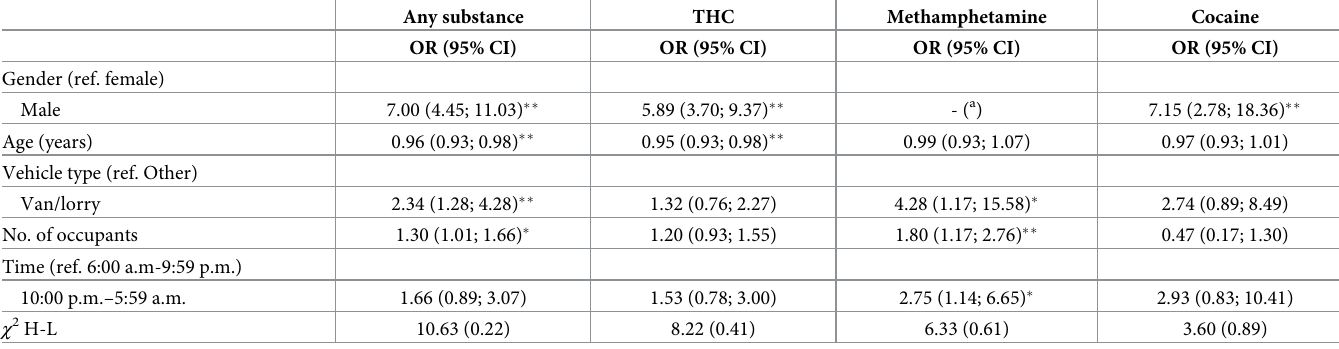
Table 4. Logistic regression model for the presence/absence of any substance, THC, methamphetamine or cocaine. Any substance THC